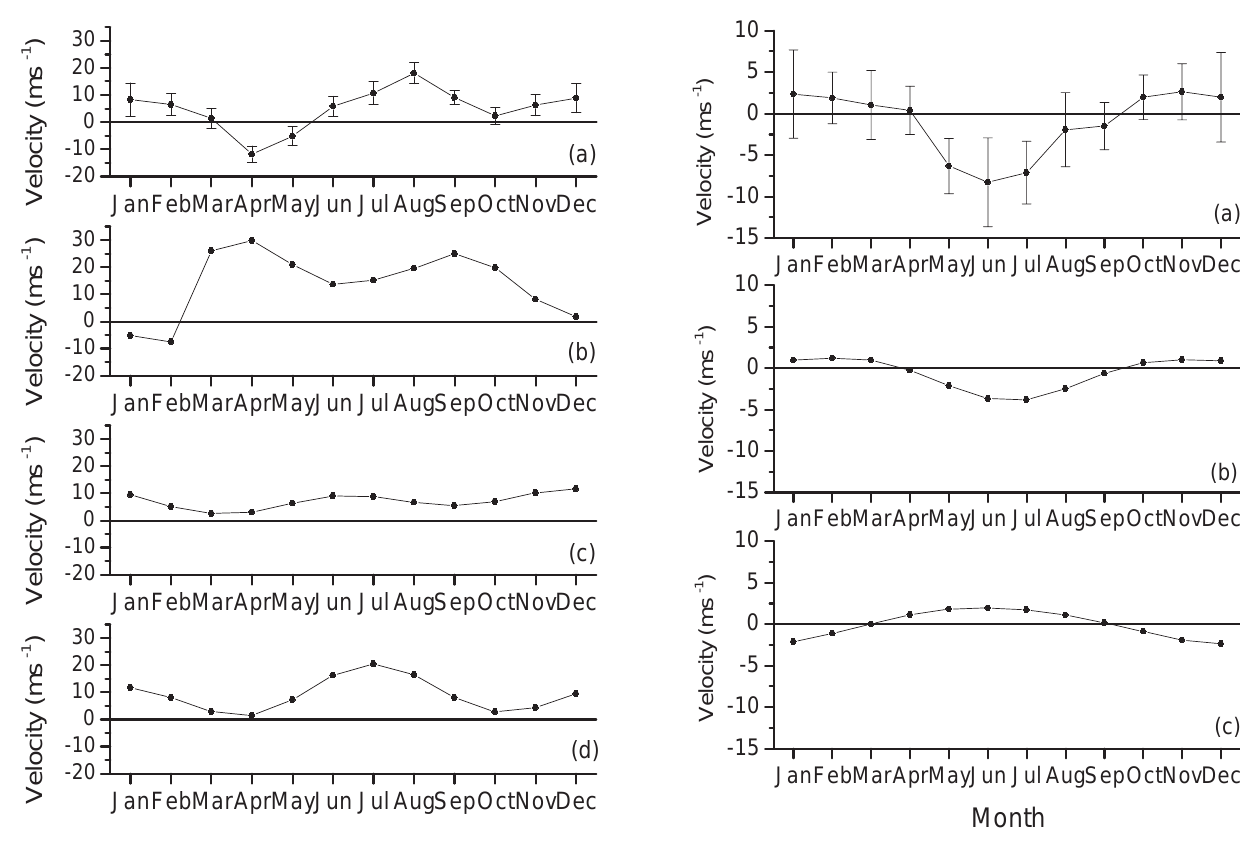
Fig. 3. Observed and model meridional winds (positive winds are northwards/poleward): (a) Observed monthly-mean meridional wind, 1988–2000; error bars indicate standard deviations. (b) HWM-93 meridional winds for 90 km (c) HWM-93 meridional winds for 95